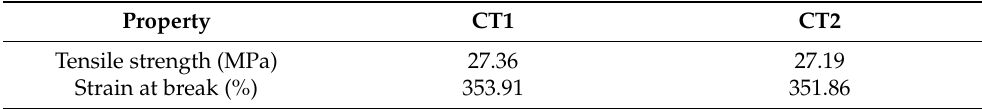
Table 3. Predicted strength